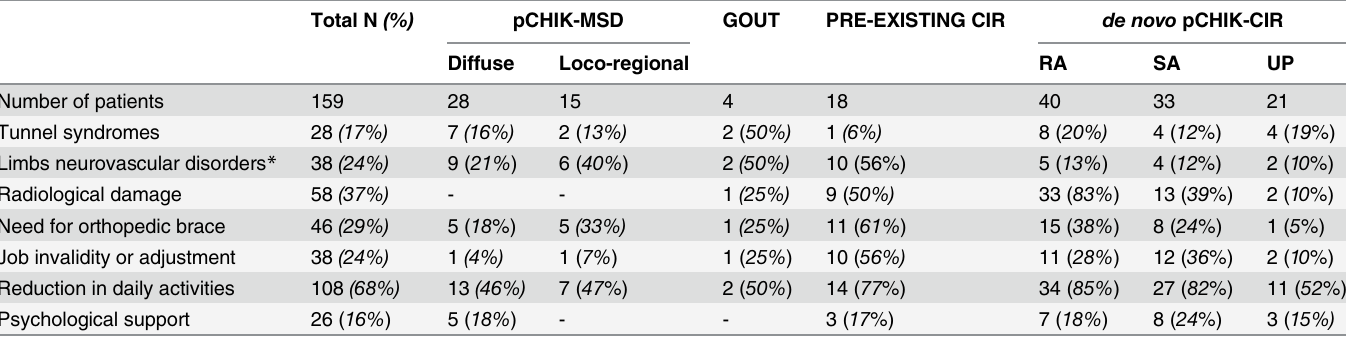
Table 4. Medical features in the different groups of post-chikungunya rheumatic and musculoskeletal disorders in patients referred to a rheumatologist for persisting pains, Saint-Denis, Reunion Island, 2006 –